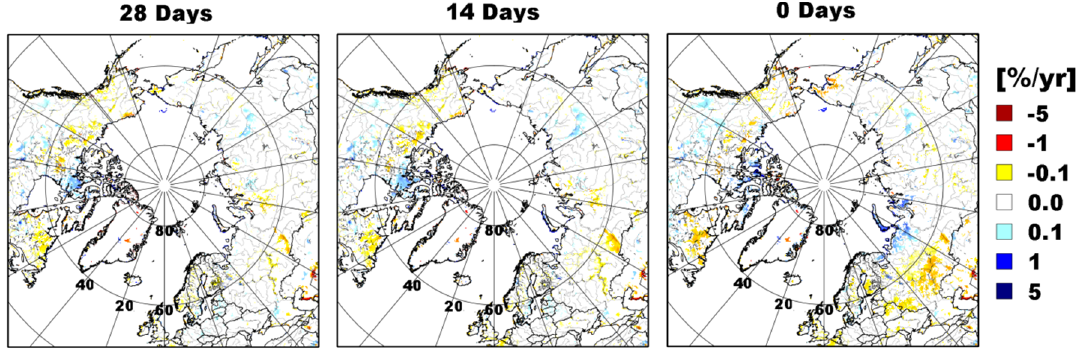
Figure 16. Same as Figure 15 but for the Arctic-Boreal as determined from v1-QSCAT (2000–2008) monthly means. Daily FW was screened from potential wet snow contamination via a 28- and 14-day long sliding mean time domain SWE filter. SWE filtering was not applied to FW for the 0-day retrieval; only pixels identified as frozen snow were removed. Actual figure color is a linear interpolation of the colors in the legend. All maps in northern hemisphere Equal-Area Scalable Earth (EASE) grids projection with the North Pole at the center of the map. Distance covered by one degree of latitude is approximately